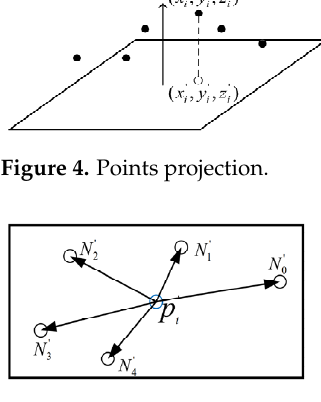
Figure 5. Projection vectors.